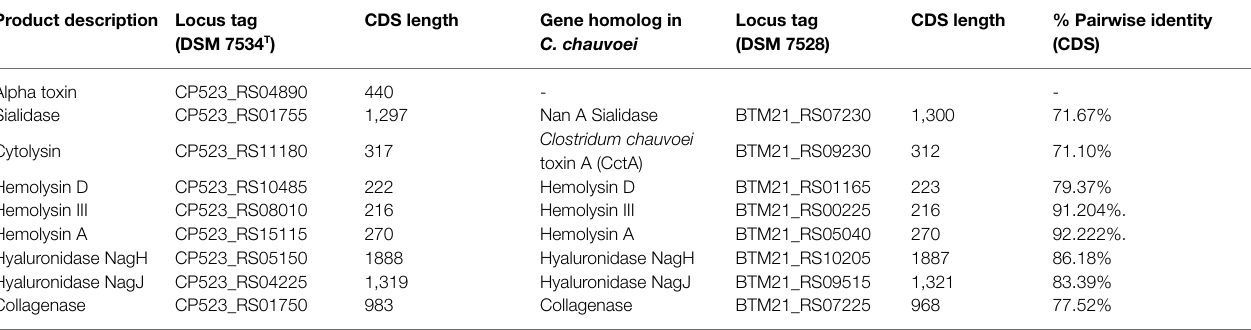
TABLE 6 | Virulence factors predicted for Clostridium septicum